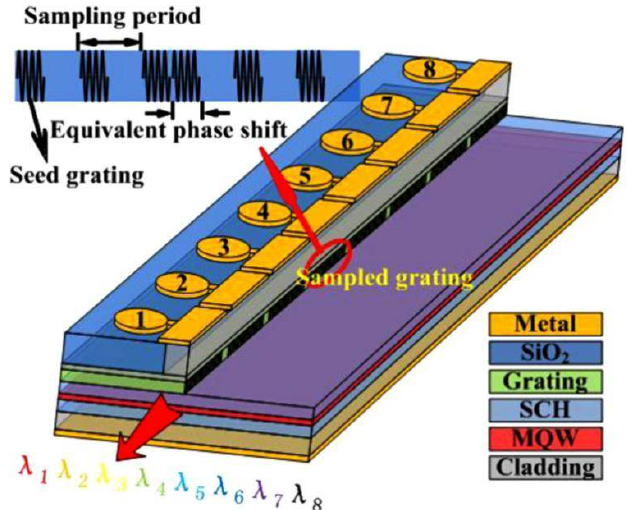
Figure 3. Series DFB laser array [16] © Elsevier. Copyright 2015 optics communications.